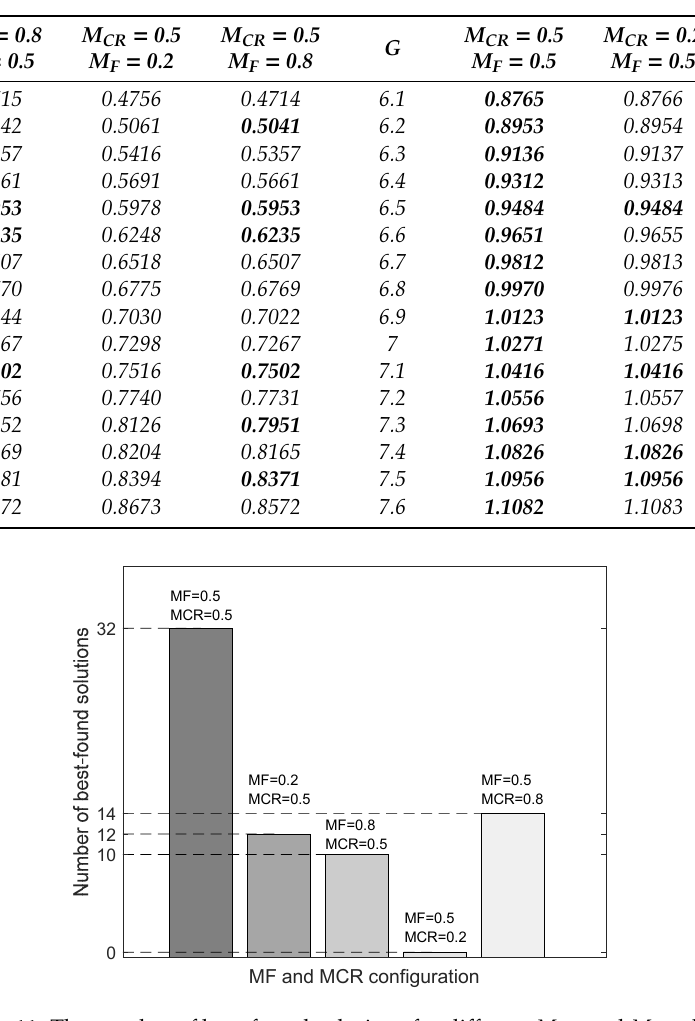
Table 2. Comparative table of the obtained results using di ff erent M CR and M F values.